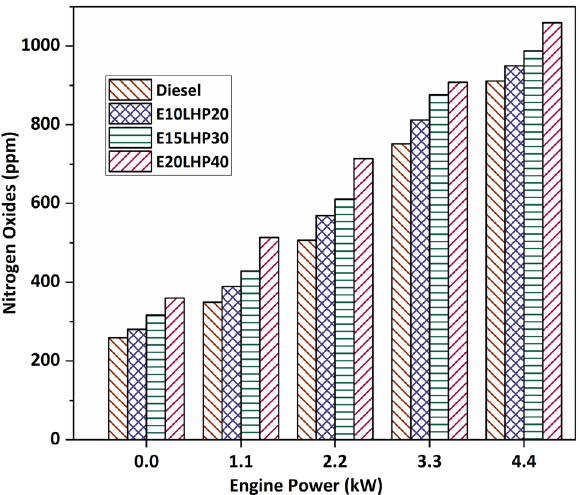
Figure 7. Impact of nitrogen oxides emissions on LHP and ethanol blends.